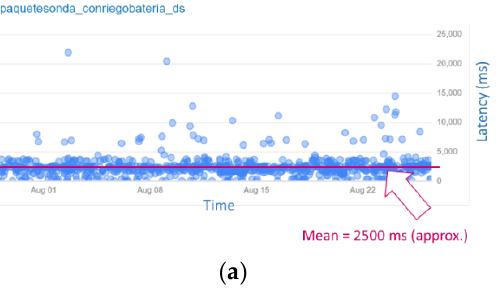
Figure 12. Latency charts for the main services. ( a ) Latency calculated for requests to the service used by data loggers to store sensor information. ( b ) Latency calculated for requests to the service used by users for downloading sensor information in a given sensor channel.